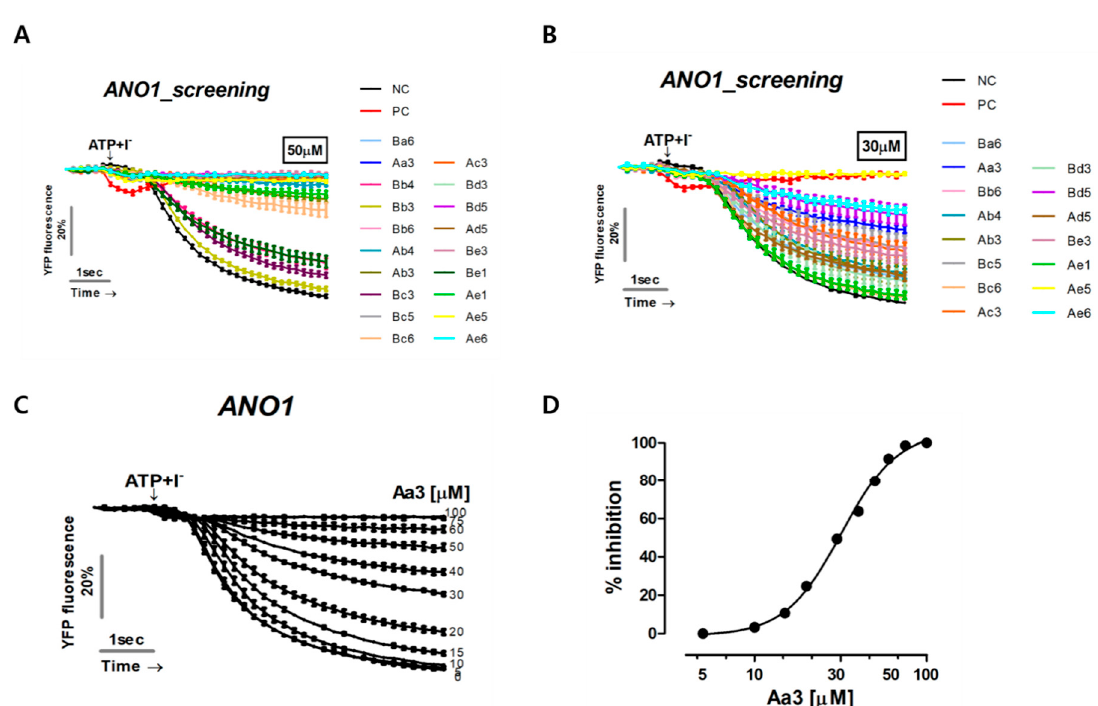
Figure 4. Identification of a novel inhibitor candidate of ANO1. The activity of ANO1, a Ca 2+ -activated Cl – channel, was assessed in Fischer rat thyroid yellow fluorescent protein (FRT-YFP) cells stably expressing ANO1. ( A ) The cells were pre-treated with 50 µM of 19-candidate compounds for 20 min, and ANO1 was activated by treating the cells with 100 µM of ATP, an agonist of P2Y receptor. ( B ) Fifteen-compounds, which were noteworthy, were selected. Subsequently, ANO1 activity was re-measured in a lower concentration of 30 µM. ( C ) The selected Aa3 compound inhibits the activity of ANO1 in a dose-dependent manner. ( D ) IC 50 -curve of Aa3 (mean ± S.E. n = 3). NC; negative control (DMSO-treated cells), PC; positive control (cells treated with NPPB known as a chloride channel inhibitor).